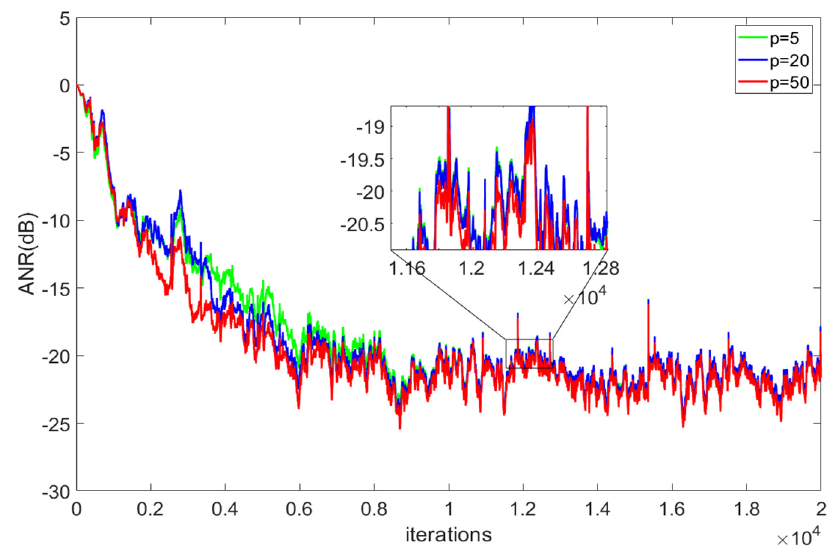
Figure 6. Performance of the ASSFxLMSPSO algorithm under different particle numbers.